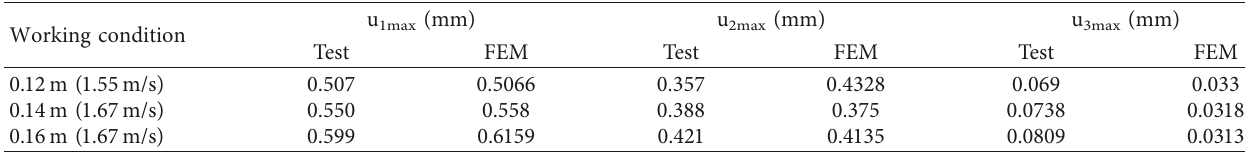
Figure 6: Displacement of pile body under impact of 0.16m pendulum height. (a) Maximum lateral displacement; (b) time history curve of u1; (c) time history curve of u2; (d) time history curve of u3. Table 2: Maximum displacement of two measuring